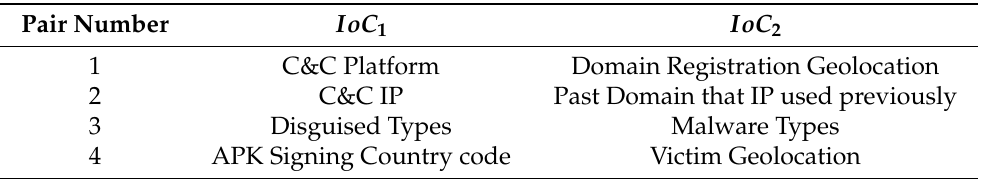
Table 1. This paper developed four types of indicator of Compromise(IoC) pairs to avoid false flags considering the correlation between